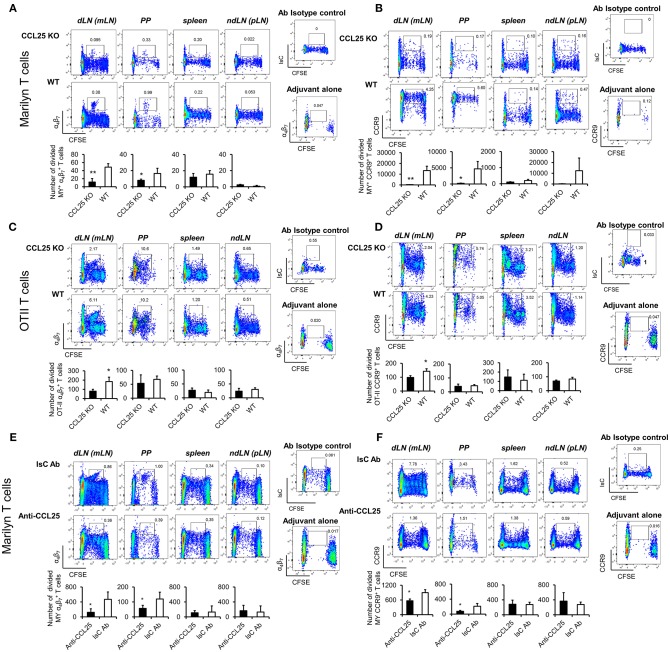
CCL25 promotes differentiation of an antigen-specific, α4β7high CD4+ T cell population. TCR-transgenic, MY (A,B) or OT-II (C,D) naïve T cells (107/mouse) were labeled with CFSE (4 μM) and injected intravenously into WT and ccl25−/− syngeneic female recipients. Twenty-four hours later, recipient mice received cognate peptide (100 μg Dby or 0.5 μg OVA-DEC peptide) plus ODN adjuvant (50 μg/mouse) orally. As a control, some mice received adjuvant only (ODN alone). Five days after immunization, T cells were separately harvested from mesenteric LN (draining LN, dLN), Peyer's Patches (PP), inguinal and axillary (non-draining LNs, ndLN) and the spleen. T cells were identified by gating on the CD4+ Vβ6+ (MY) or Vβ2+ (OTII) lymphocyte populations. Expression of α4β7
(A,C) and CCR9 (B,D) by divided T cells was assessed by flow cytometry. In similar experiments depicted in panels (E,F), CD4+ T cells from Marilyn mice (MY 107/mouse) were labeled with CFSE (4 μM) and adoptively transferred into syngeneic female recipients, which received an intraperitoneal injection of CCL25-neutralizing antibody (Anti-CCL25, 10 mg/kg) or Isotype Control antibody (IsC Ab). Twenty-four hours later, recipient mice received cognate Dby peptide (100 μg) plus ODN adjuvant (50 μg/mouse) orally. Five days after immunization, T cells were separately harvested from mesenteric LN (draining LN, dLN), Peyer's Patches (PP), inguinal and axillary (non-draining LNs, ndLN) and the spleen. T cells were identified by gating on the CD4+ Vβ6+ (MY) lymphocyte populations. Expression of α4β7
(E) and CCR9 (F) by divided T cells was assessed by flow cytometry. In all panels, the mean number of divided α4β7+ and CCR9+ T cells from three independent experiments of identical design is shown below a set of representative dot plots (±SD). Staining with an isotype-matched control antibody and proliferation and differentiation in draining lymph nodes of mice injected with adjuvant alone are shown on the right-hand side of each set of dot plots. To avoid the reciprocal effect of the presence of other responder T cell populations, results are presented as absolute numbers. *p < 0.05, **p < 0.01.